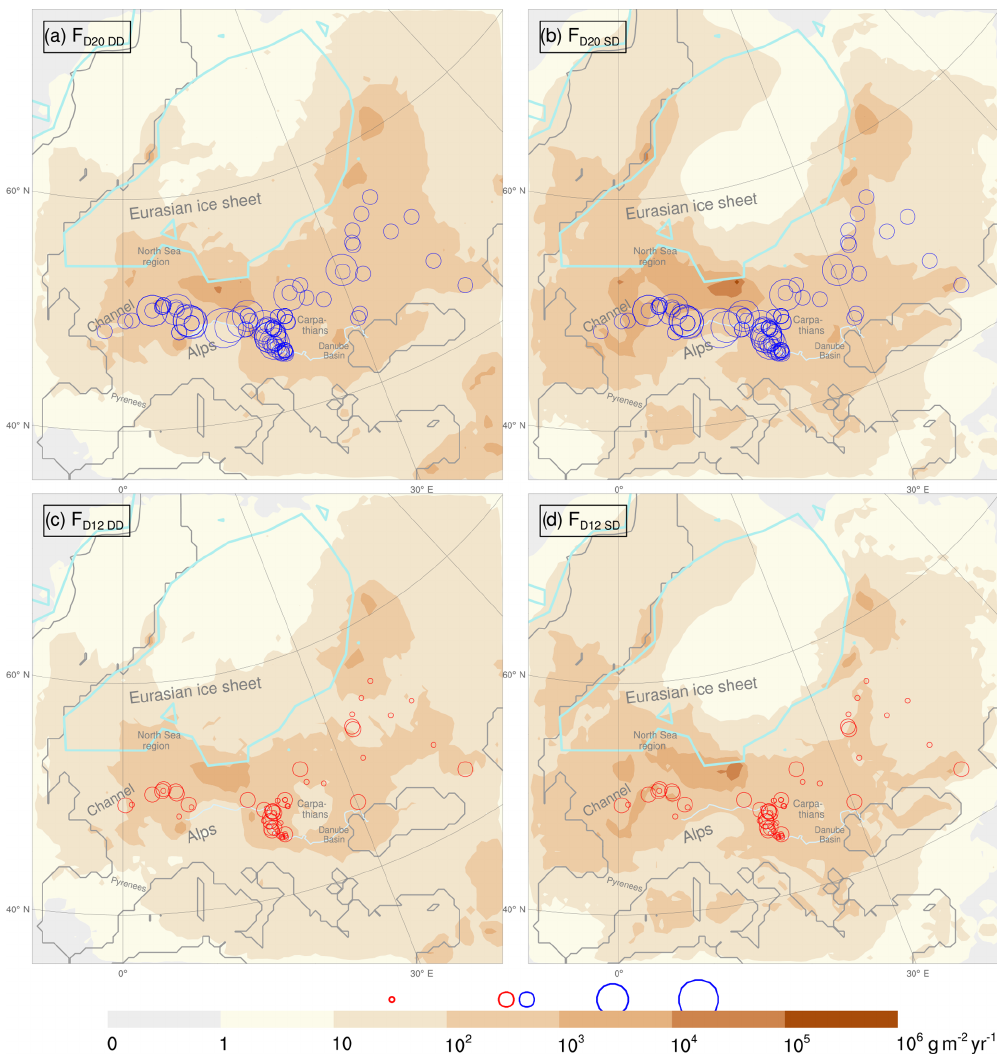
Figure 4. Dust deposition rates for the Last Glacial Maximum, comprising particles of up to 20µm in diameter ( F D20 ) using (a) dy- namic downscaling ( F D20DD ) and (b) statistic dynamic downscaling ( F D20SD ). Panels (c) and (d) are as (a) and (b) , but for particles up to 12µm ( F D12 ). Each blue circle size represents one mass accumulation rate (MAR, Table S1 column 5) magnitude. Each red circle size represents one reduced mass accumulation rate (MAR10, Table S1 column 6) magnitude. MAR and MAR10 values compiled in Table S1. The simulation-based ( F D20 , F D12 ) and the fieldwork-based (MAR, MAR10) rates result from independent data. Delineated are the Danube (light blue), the coastlines (grey; Braconnot et al., 2012), and the ice sheet extents (turquoise; Cline et al.,